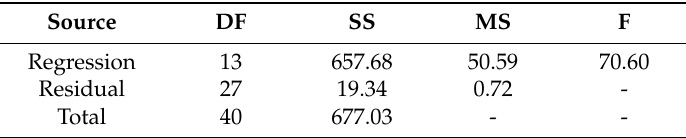
Table 6. ANOVA Table for RF during steamflooding.